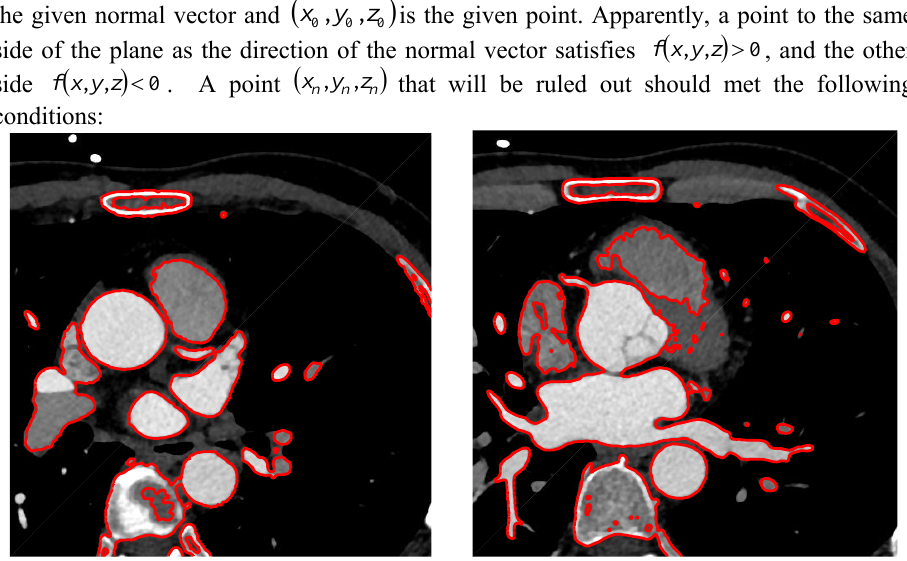
Fig. 6. CAD segmentation based on 2D CTA